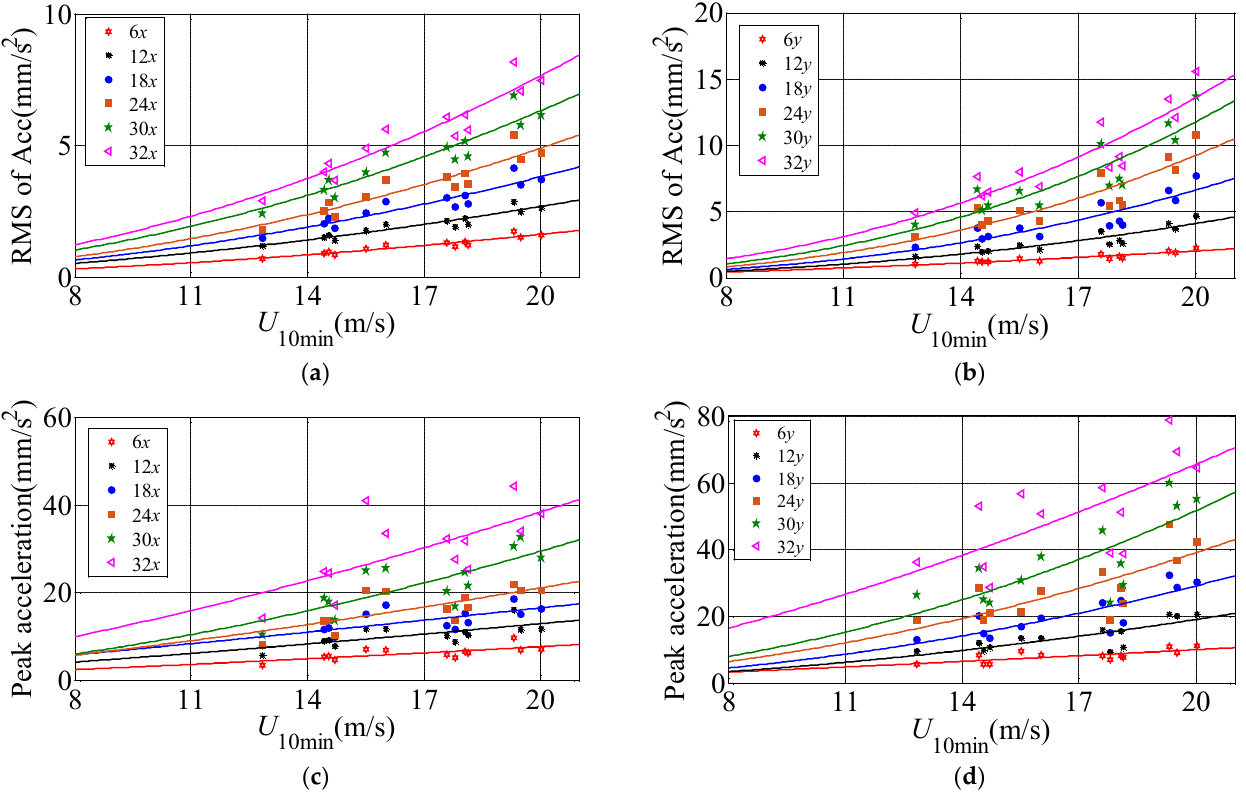
Figure 7. The relationship between the RMS of Acc and peak acceleration along longitudinal and lateral directions of the measured six floors with respect to the mean wind speed. ( a ) RMS of Acc along x -axis; ( b ) RMS of Acc along y -axis; ( c ) Peak acceleration along x -axis; ( d ) Peak acceleration along y -axis. Table 2. The fitting results of translational parameters of c 1 and c 2.